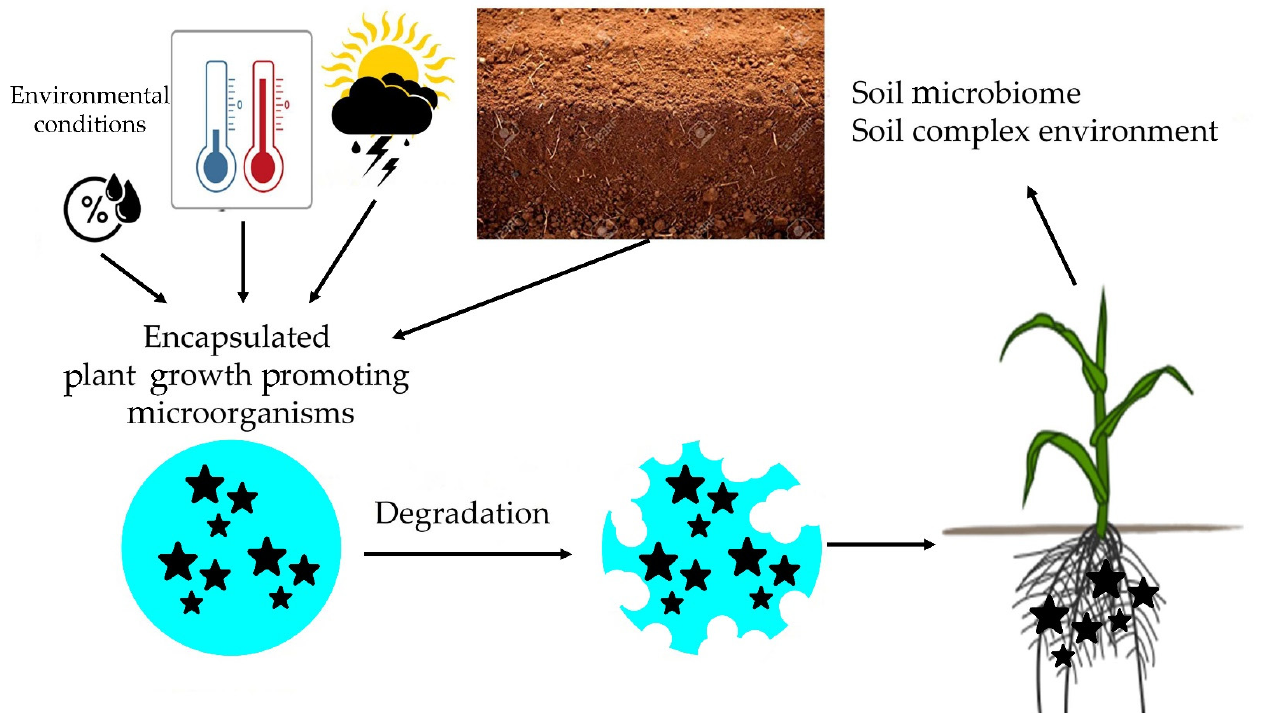
Figure 1. Encapsulation of PGPMs and how to use them in plant fertilization. Formulations immobilized in microparticles (1 mm in diameter) seem to be able to